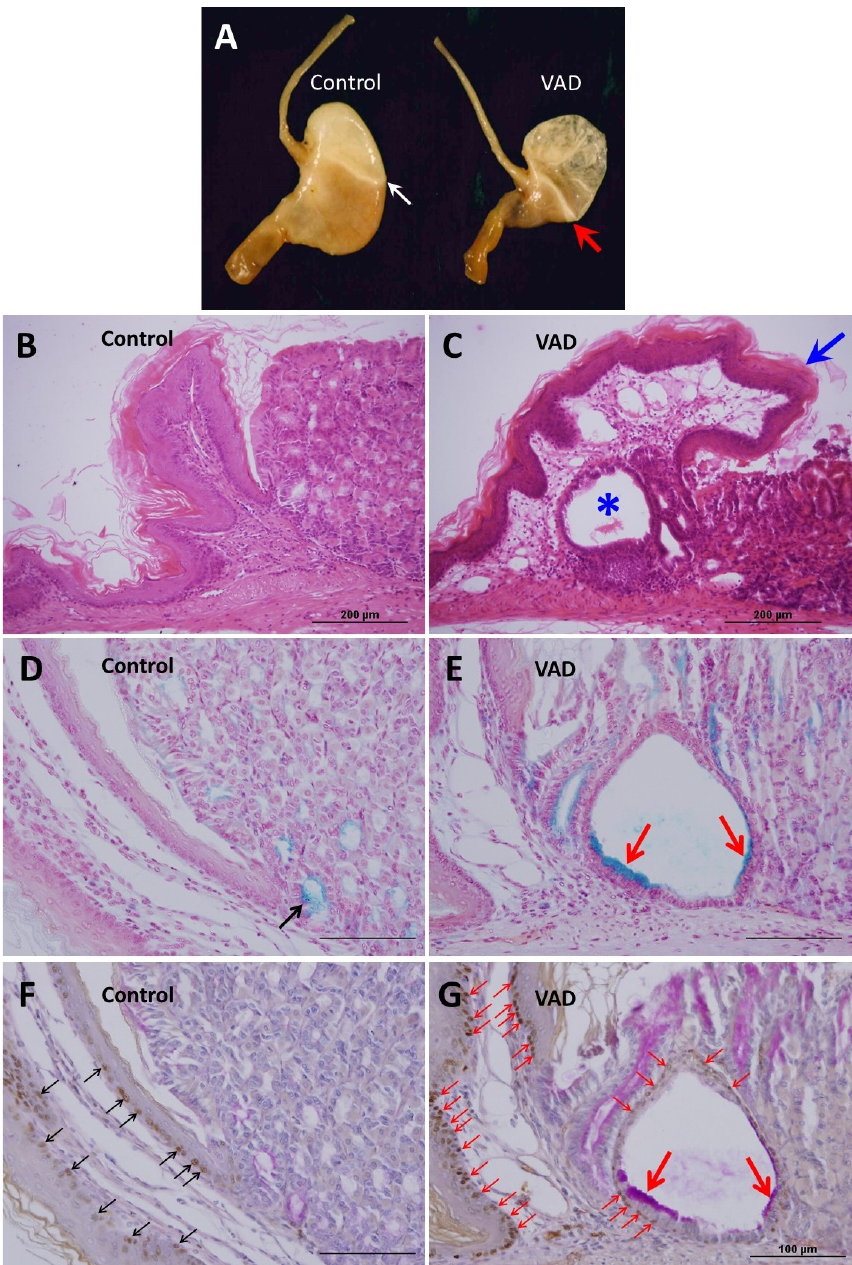
Figure 3. Characterization of the stomachs in 8-month control ( A , B , D , F ) and VAD ( A , C , E , G ) mice. ( A ) Enlarged forestomach of VAD mouse with prominent limiting ridge (white vs. red arrows) at the border with glandular region. ( B , C ) Tissue sections of control ( B ) and VAD ( C ) stomachs stained with H&E showing the protruding limiting ridge (blue arrow) folding over the luminal surface of the glandular region (arrow). Note the cystic structure in the VAD tissue (asterisk). ( D , E ) Alcian blue staining in control ( D ) and VAD ( E ) tissue shows a few bluish mucous cells in the bottom of the cardiac glands. The mucosal cyst of VAD ( E ) tissue shows Alcian blue positive mucus-rich luminal cells. ( F , G ) Immunolocalization of p63 showing positive staining in the basal layer of the stratified squamous epithelium of forestomach in control ( F , multiple black arrows) and in VAD ( G ) tissue, demarcating the epithelial basal layer of both forestomach and the mucosal cyst (multiple small red arrows). Counterstaining with PAS labels the luminal mucous cells of the cyst (big arrows). Scale bar = 200 µ m ( B , C ) and 100 µ m ( D – G